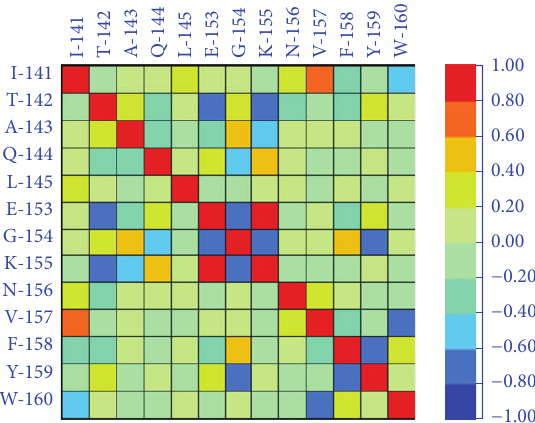
Figure 3: Pairwise positional correlation estimation of WOX sequences. The pairwise positional correlation estimation was analyzed by CRASP (http://www.bionet.nsc.ru/en). Two regions within the homeodomain, one is from 141 (I) to 145 (L) and the other is from 153 (E) to 160 (W), were closely correlated. The color refers correlation coefficiency of the amino acid at a certain position.